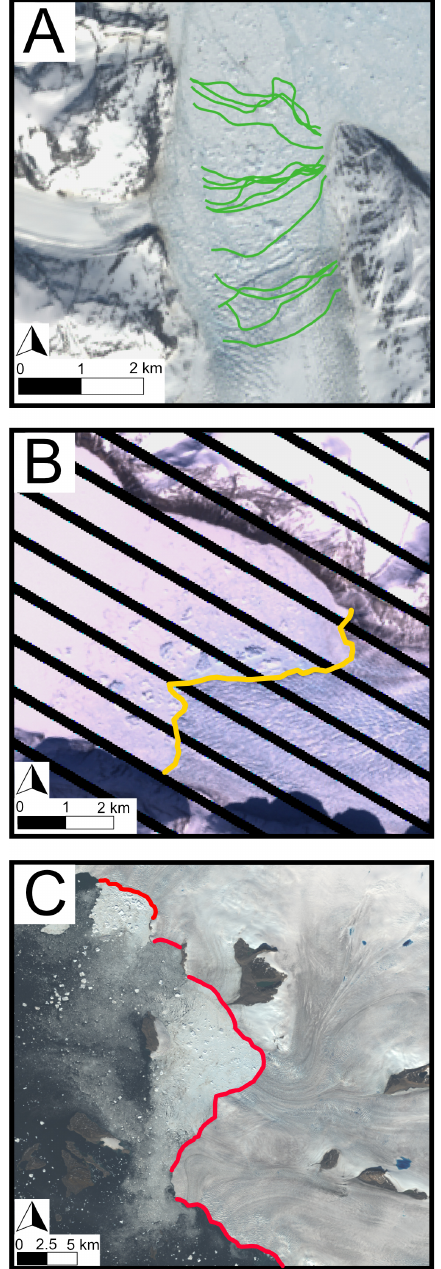
Figure 2. Common issues addressed in data cleaning and labeling. (a) Box method glacier traces are contained within a box that is smaller than the full terminus width at Glacier 224, (b) Landsat 7 ETM+ Scan Line Corrector (SLC)-off image line artifacts at Glacier 291, and (c) a single shapefile containing several different glaciers (IDs 27–30) that need to be split manually into separate glaciers to be consistent with the ID scheme. Additionally, all three images show varied levels of obstruction of the terminus in the fjord due to ice mélange. Landsat-7 and Landsat-8 images courtesy of the U.S. Geological